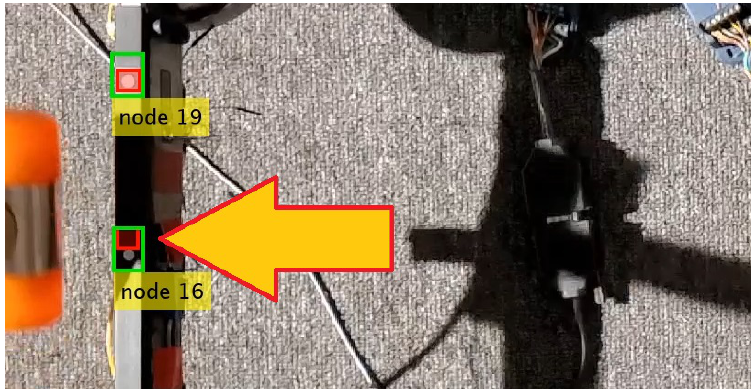
Figure 7. Example of the template mismatch caused by the shadow of the rubber hammer.